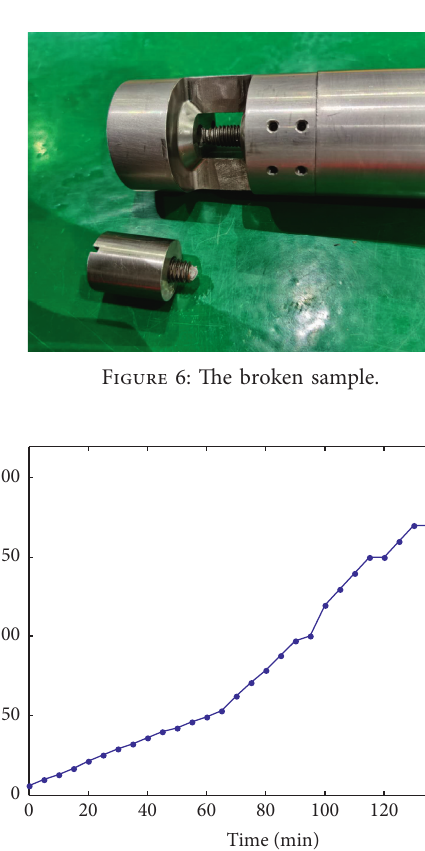
Figure 7: Values in vacuum pressure maintaining